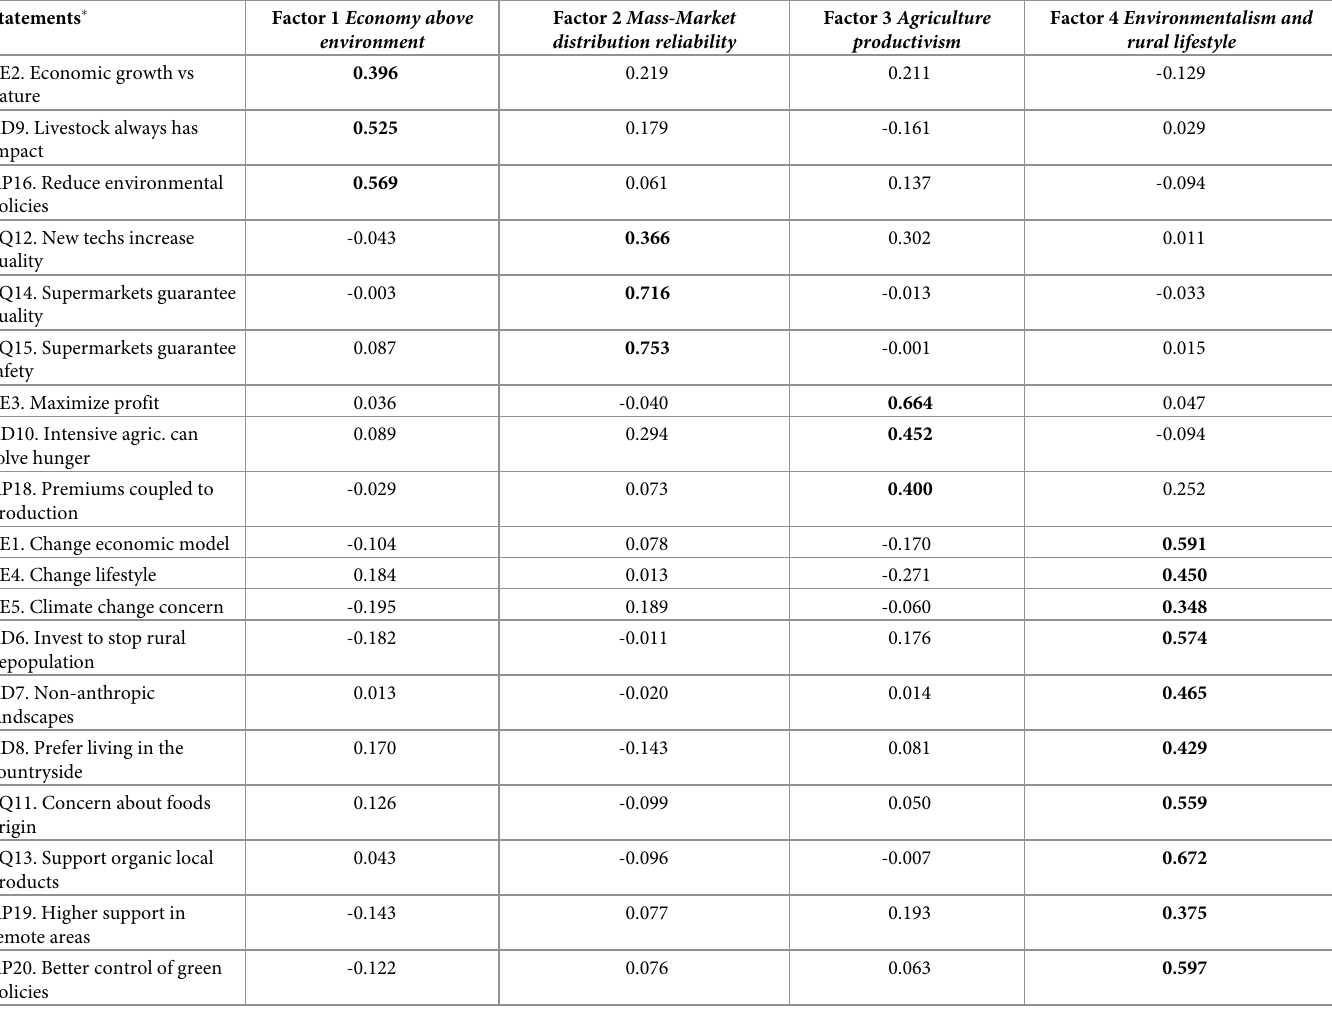
Table 2. Configuration matrix of the 19 statements factor loadings for attitudinal factors (oblique